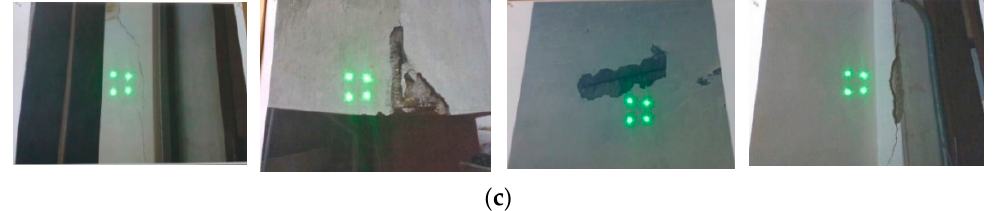
Figure 10. The captured images with the slope of: ( a ) 0 degrees; ( b ) 5 degrees; and ( c ) 10 degrees. Table 3. Relative error of quantification results according to slope (0, 5, and 10 degrees). Slope (Deg.) Min Max